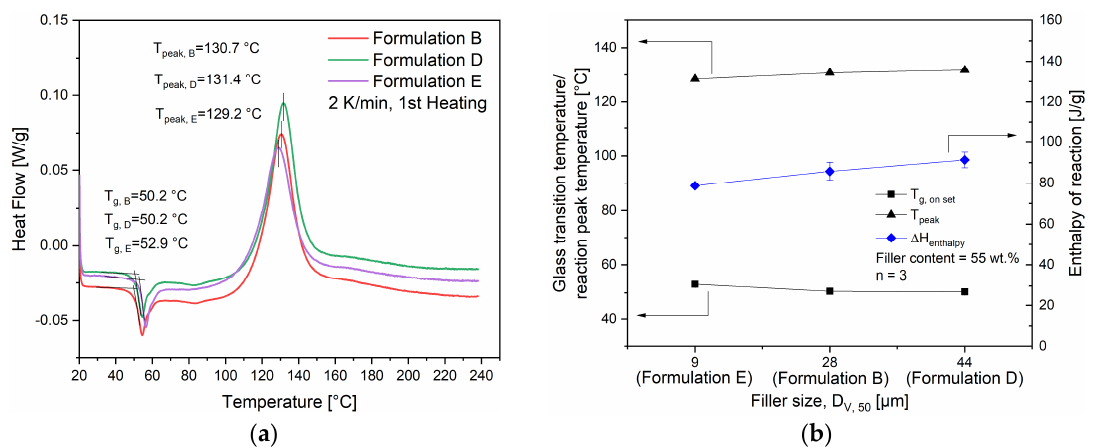
Figure 8. ( a ) The representative DSC dynamic measurement curves of formulations with the same filler size, but different filler contents, ( b ) Influence of filler content on the glass transition temperature T g , the reaction peak temperature T peak and the enthalpy of reaction Δ H total of compounds.